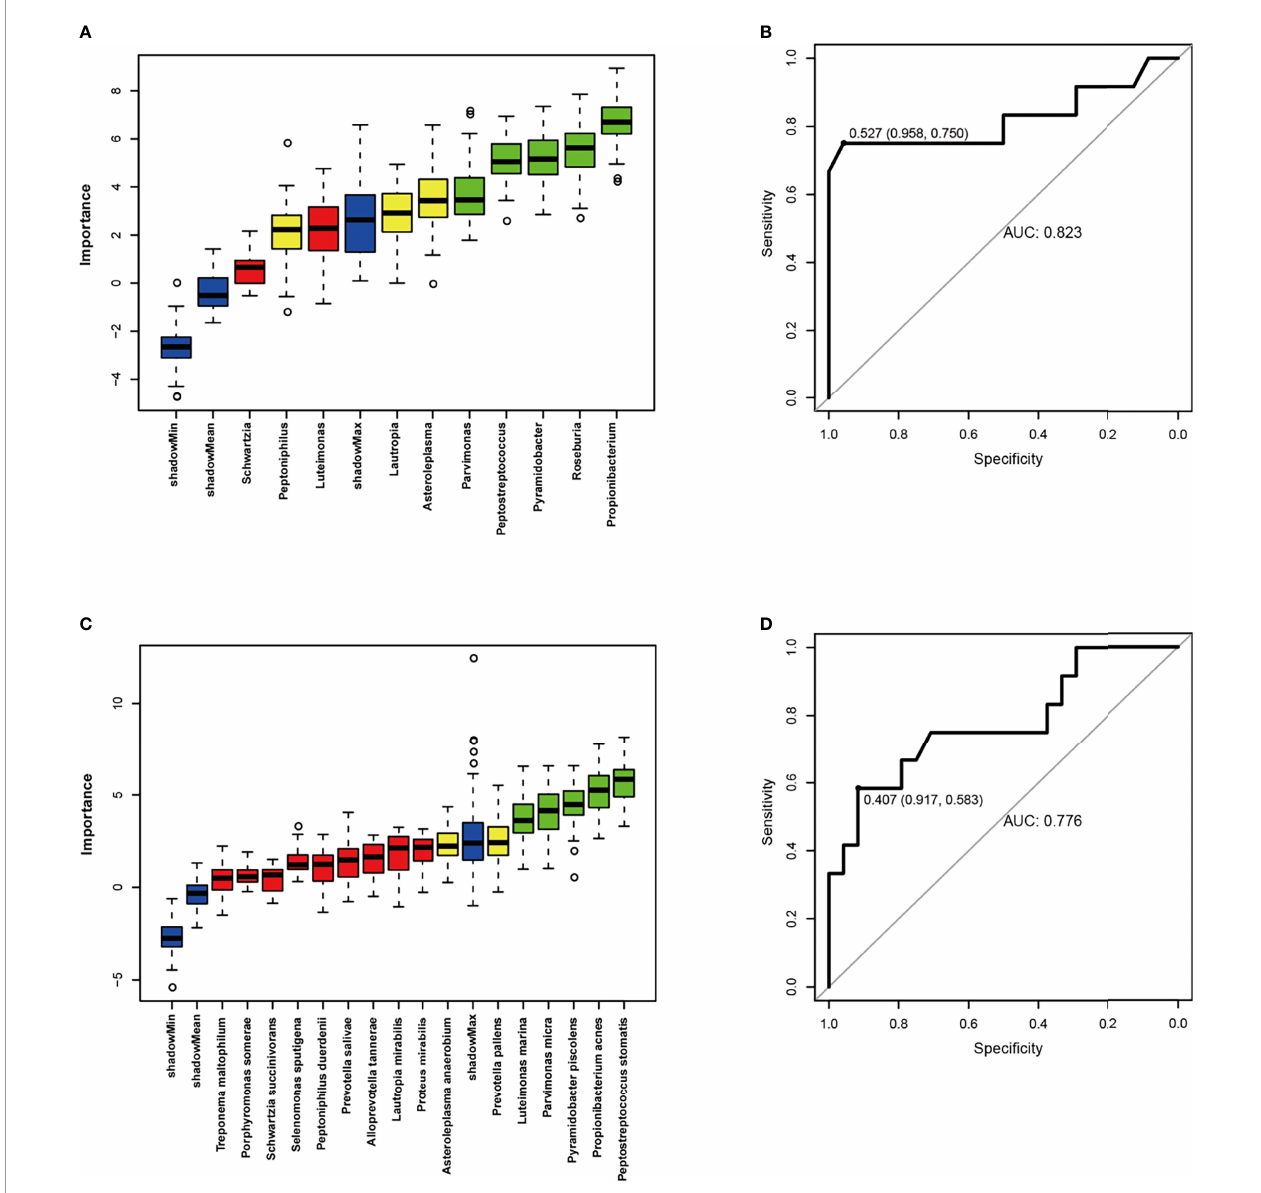
FIGURE 5 | ROC curve analyses were performed to evaluate the diagnostic performance of oral microbiome for OSCC metastasis. (A, C) Boruta algorithm was used for feature selection and to assess the importance of variables. (B, D) ROC curves were constructed to predict diagnostic power of microbiome for tumor metastasis. It suggested that higher abundance of Lautropia, Asteroleplasma, Parvimonas, Peptostreptococcus, Pyramidobacter, Roseburia and Propionibacterium in the tumor tissue appeared to be associated with higher rates of tumor